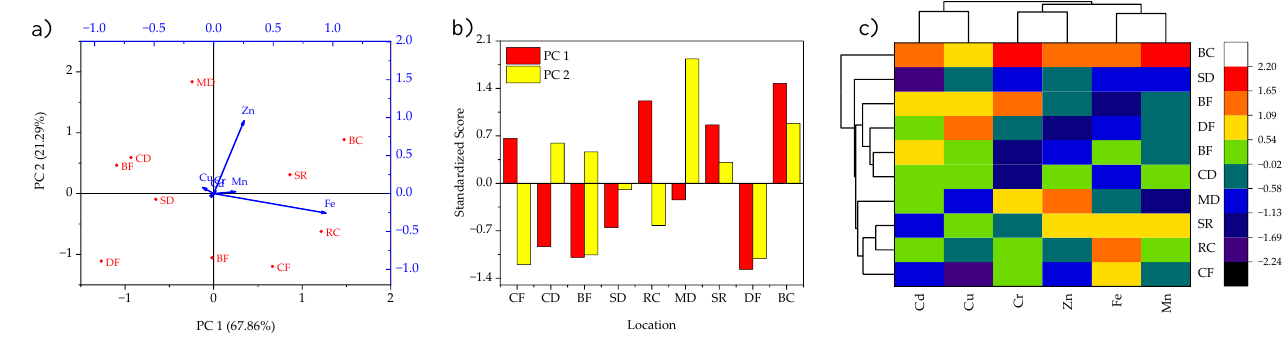
Figure 3. ( a ) Axial biplot; ( b ) PCA-standardized scores and ( c ) HCA dendrogram with heatmap for heavy metal contents in P. djamor collected from different locations of Rajaji National Park, Haridwar, India.